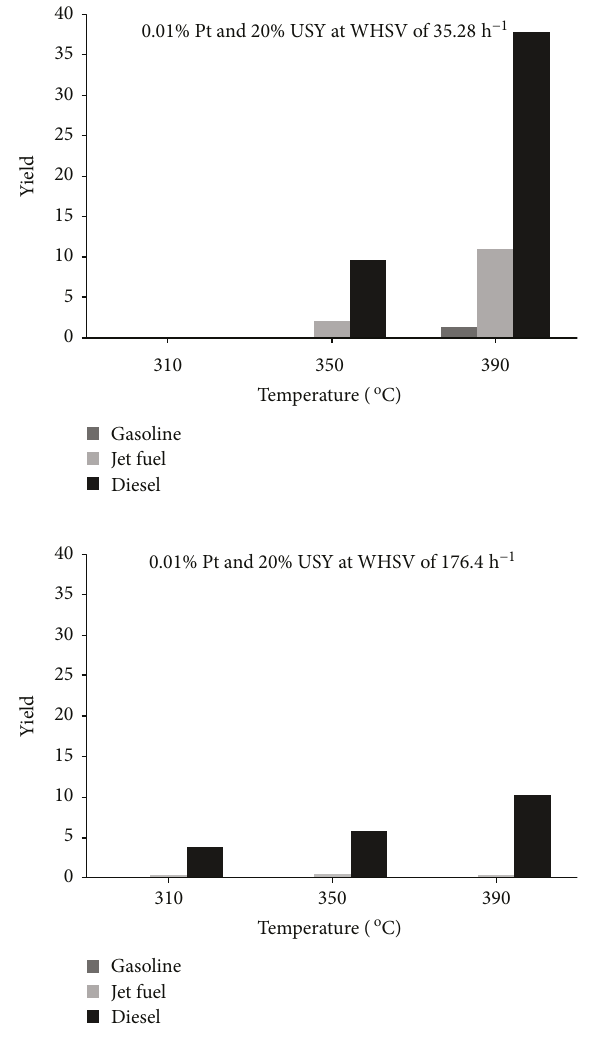
Figure 8: Yield in hydrocarbon cuts as a function of temperature and WHSV with bifunctional catalyst 0.01% Pt and 20% USY/Al